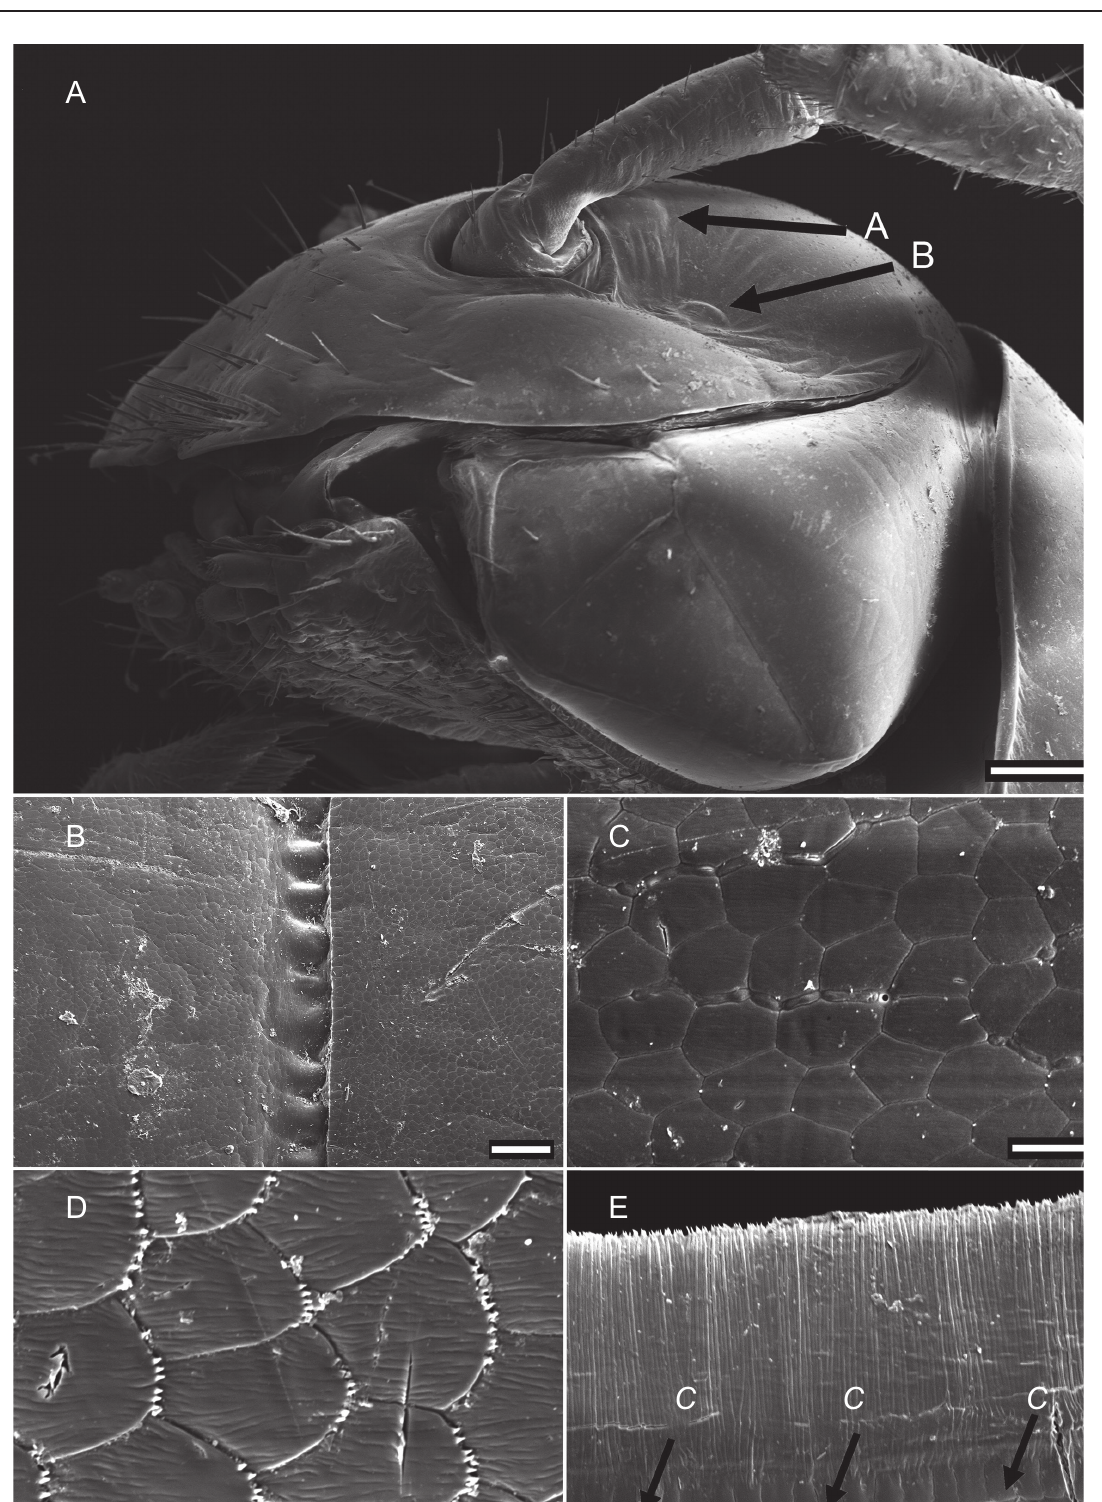
Fig. 2. A . Head, left lateral view Pogonosternum montanum Decker, sp. nov. (AMS KS106884). B–E . Midbody ring structure of P. nigrovirgatum (Carl, 1902) (NMV K-12158). B . Suture between prozonite (right) and metazonite (left). C . Metatergite surface with micro-scales and pores. D . Ventral metazonite surface. E . Limbus, dorsal view. Abbreviations: A = beanshaped area; B = lateral circular area; C = micro-pores. Scale bars: A = 0.2 mm, B = 50 µm, C–E = 10